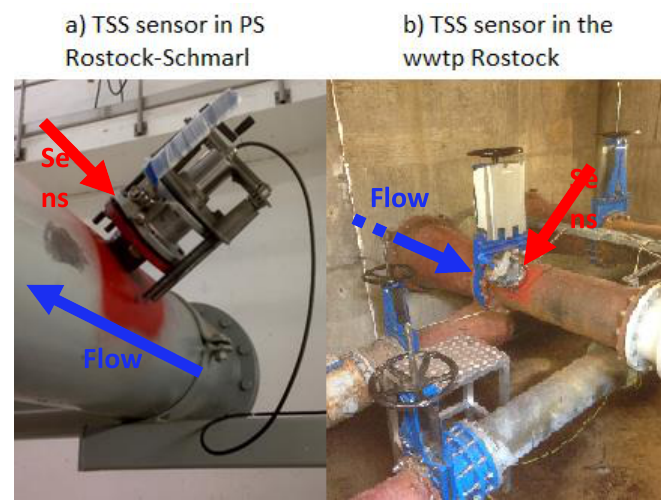
Figure 2. TSS sensors for monitoring sediment flux in pressure pipes. ( a ) TSS sensor in PS Rostock-Schmarl at the pressure side of the pump. ( b ) TSS sensor in the central wwtp Rostock at the outflow side of the pressure pipe.